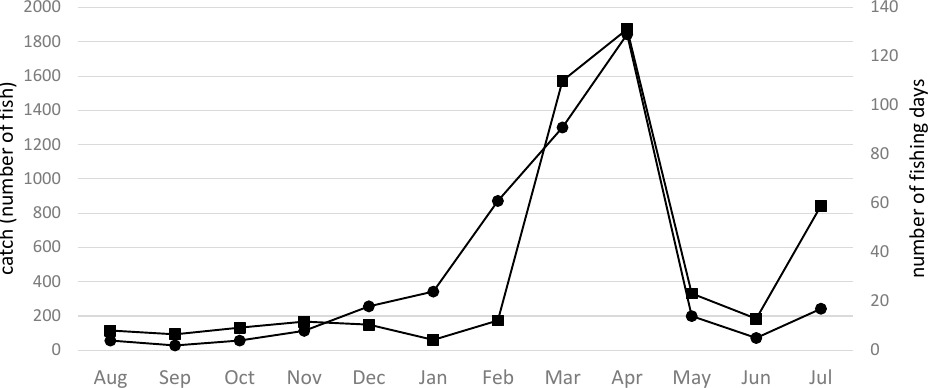
Figure 4. Number of fishing days (circle marker) and captures (square marker) reported by the fishermen between August 2016 and July 2017.